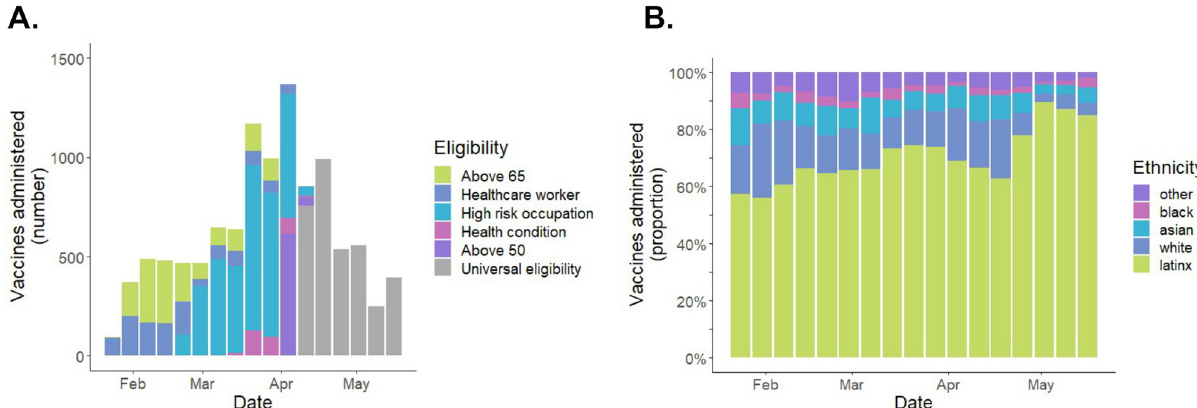
Fig 6. Temporal trends in vaccinations at the Unidos en Salud neighborhood vaccination site during the 16-week implementation period from February 1 to May 19, 2021. Panel A shows the number of vaccinations that were administered each week according to eligibility criteria indication. Panel B shows the proportion of all vaccinations each week that were administered to Latinx persons; this provides measure of how effectively Latinx individuals were reached throughout the entirety of the implementation period.